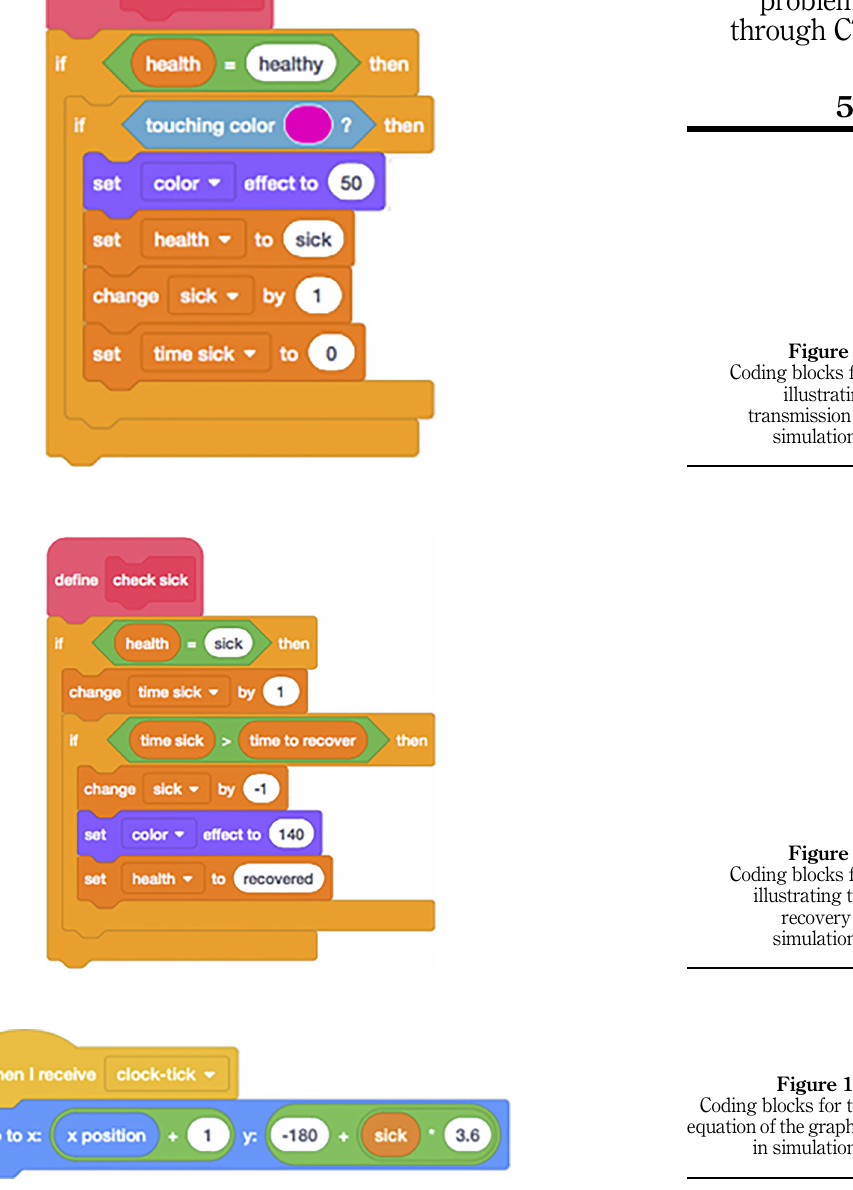
Figure 10. Coding blocks for the equation of the grapher in simulation